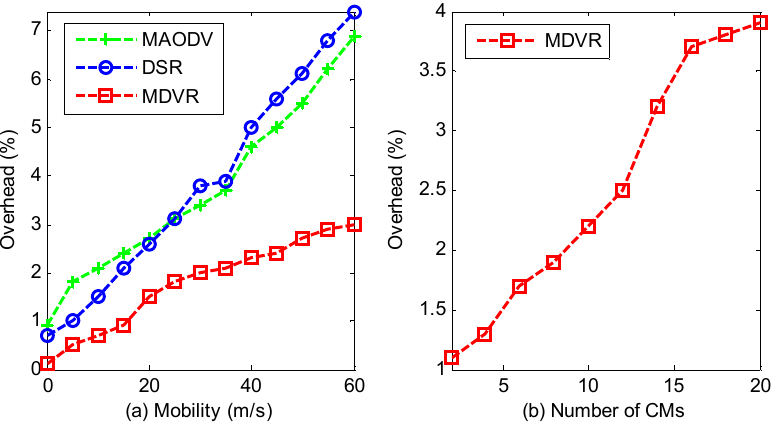
Figure 4. ( a ) UGAVs-MDVR overhead versus mobility; ( b ) UGAVs-MDVR overhead versus the number of CMs.